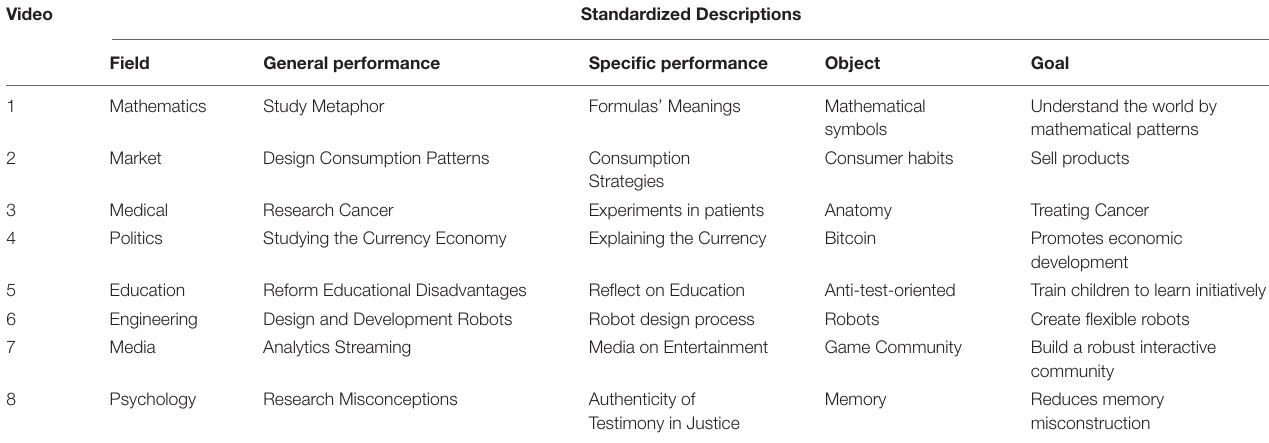
TABLE 1 | Standardized descriptions of the eight video